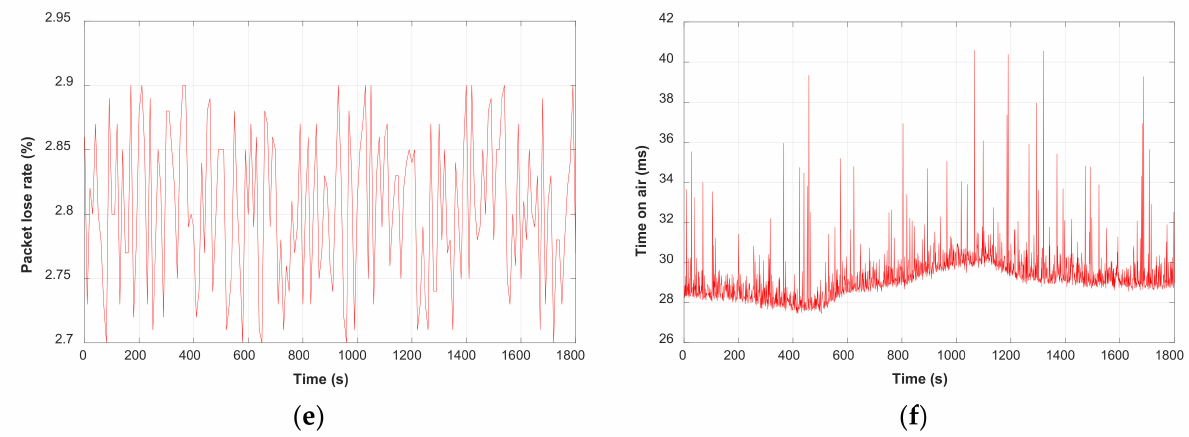
Figure 15. Measurements on the LoRa network: ( a ) frequency; ( b ) channel number; ( c ) RSSI; ( d ) SNR; ( e ) PLR; and ( f ) time on air.